Question: Looking at the figure, what chart type is it?
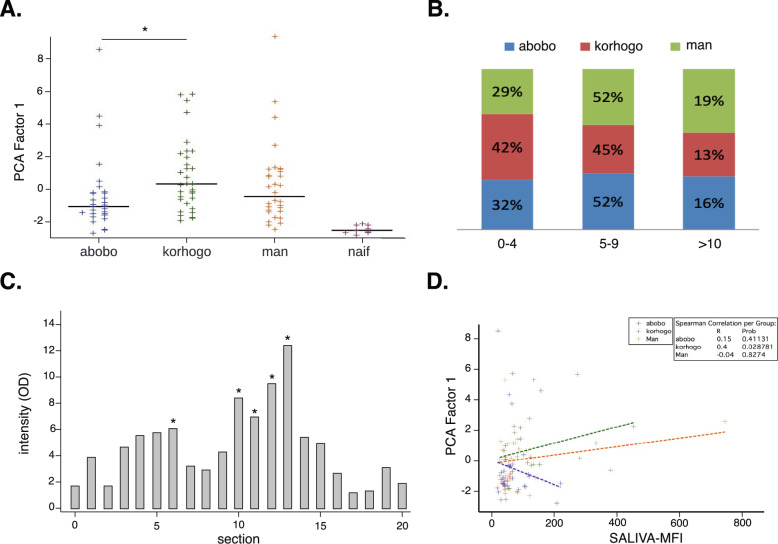
Answer: scatter